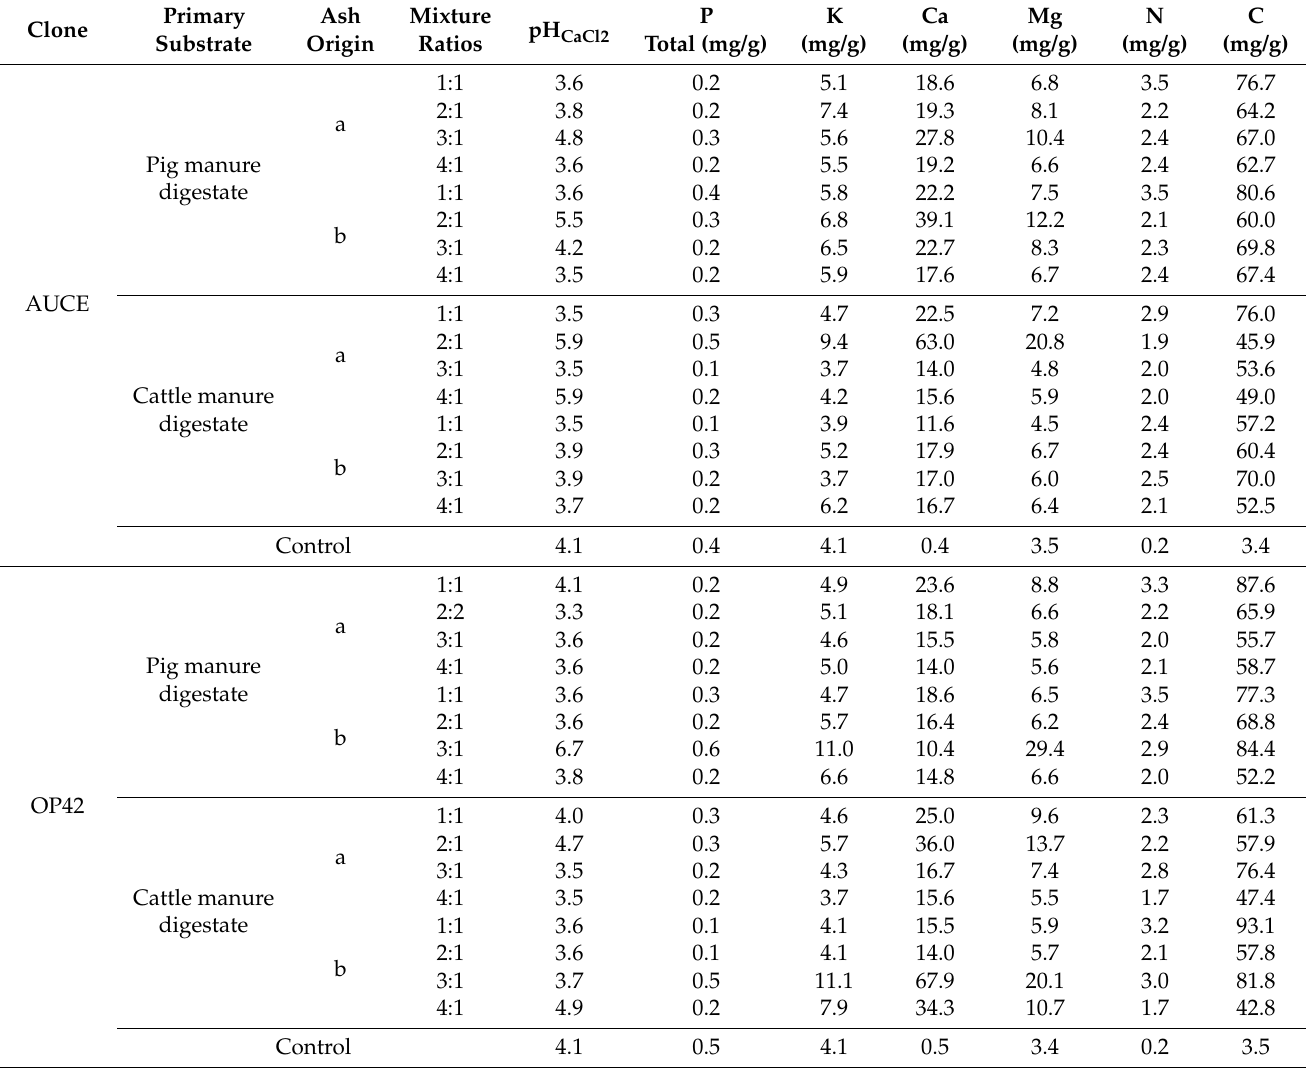
Table A2. Soil chemical composition at the end of the growth period, 26–30 August